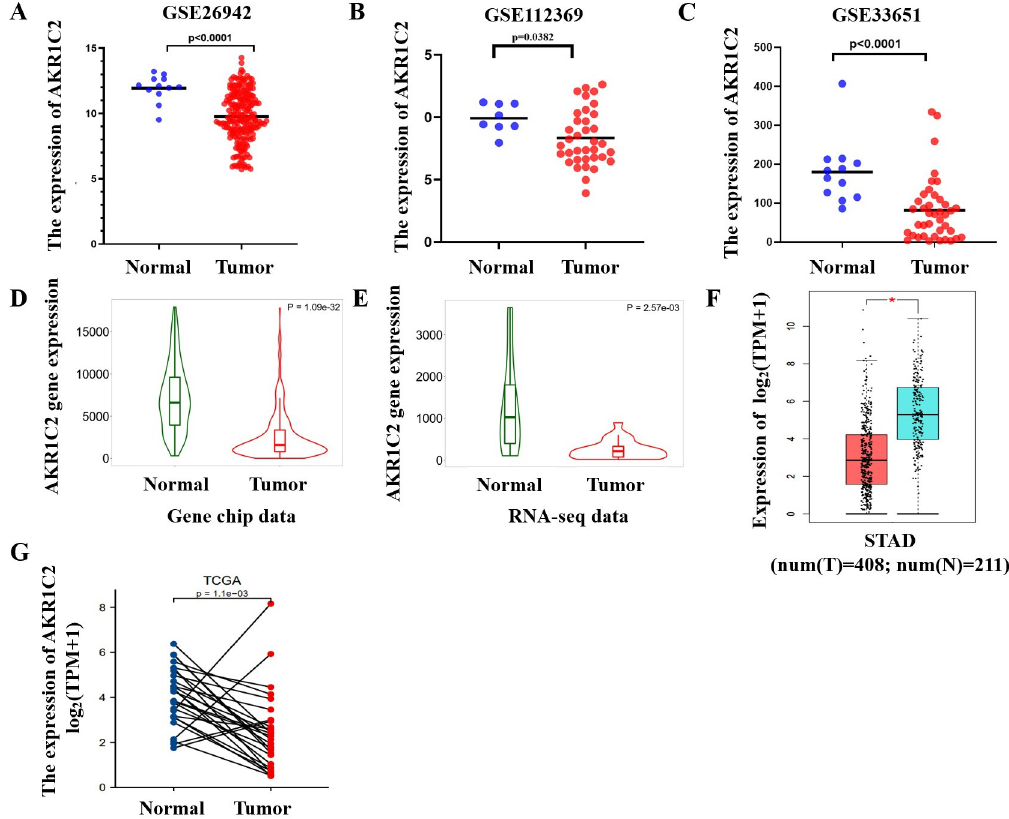
Fig 3. The expression levels of AKR1C2 in GC patients. (A-C) In the three GEO datasets, the expression level of AKR1C2 was lower in GC tissues than normal gastric tissues. (D-E) The TNMplot database illustrating the expression level of AKR1C2 was lower in GC tissues than normal gastric tissues from gene chip data and RNA-seq data. (F-G) The GEPIA 2.0 database and TCGA database depicting AKR1C2 expressed differently in GC group and non-cancerous group. � P < 0.05.